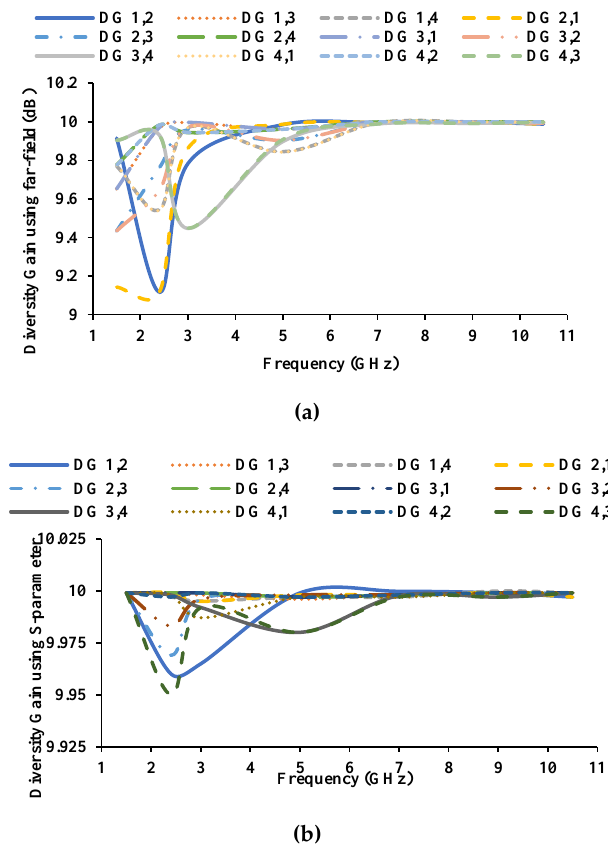
Figure 15. DG of the proposed antenna ( a ) using far-field, ( b ) using S-parameters. The total active reflection coefficient (TARC) is the square root of the summation of outgoing powers divided by the summation of incident powers at any port of an N -port antenna [35]. TARC is estimated using the Equation (7), where a i is the incident signal and b i is the received signal. TARC of the proposed antenna is less than − 10 dB, shown in Figure 16.